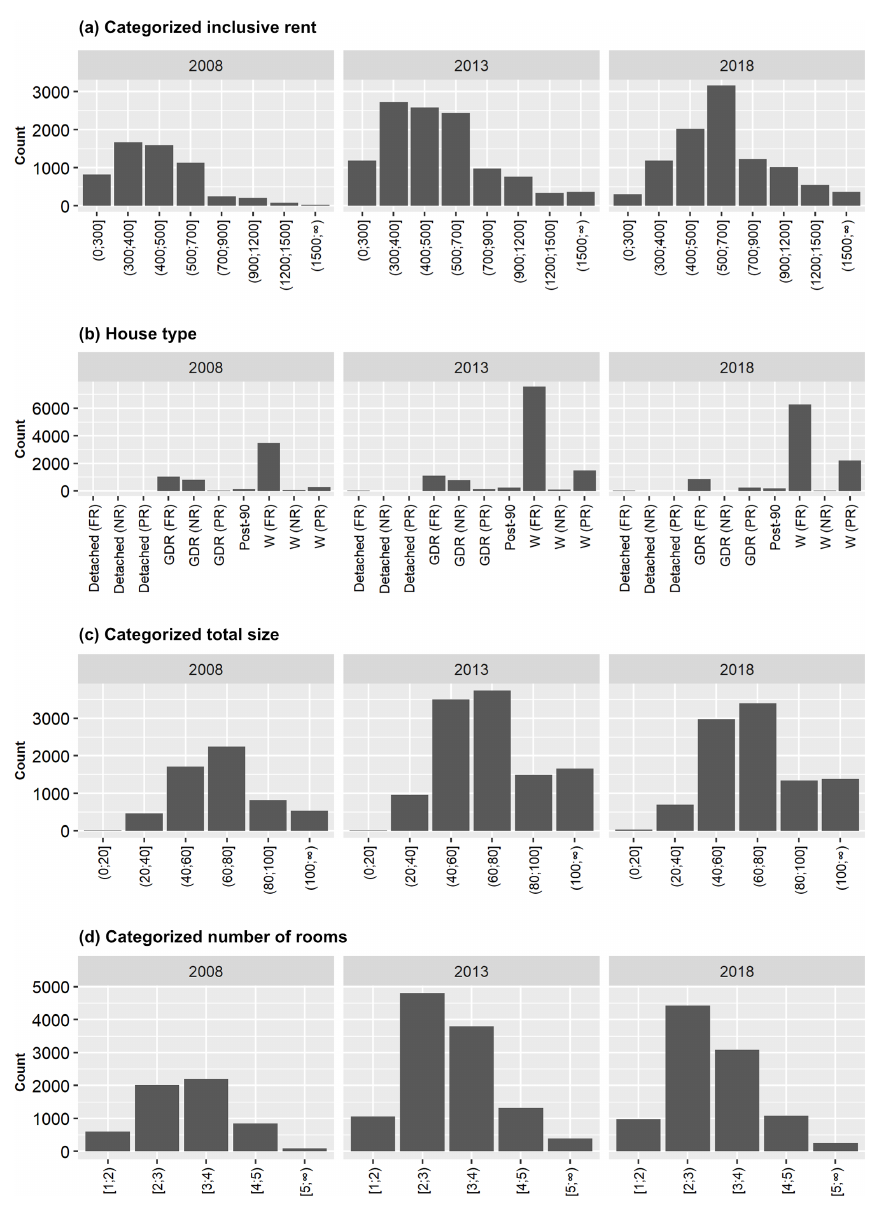
Figure 3. Characterization of the apartments offered for rent regarding predictors (a) categorized inclusive rent (rent including heating costs), (b) house type, (c) categorized total size, and (d) categorized number of rooms. For house type, GDR is equal to prefabricated housing estates, post-90 to buildings constructed post-reunification, and W to Wilhelminian-style buildings. For each house type, the condition is indicated in brackets: FR = fully renovated; PR = partly renovated; NR = not renovated. Note that condition is not differentiated for post-reunification buildings due to the random forest training